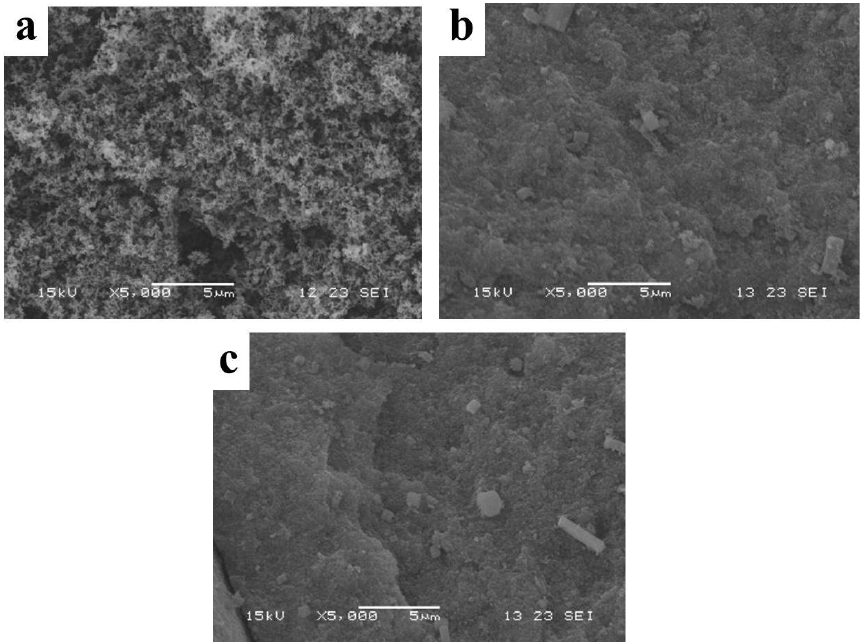
Figure 6. SEM images of ( a ) EP, ( b ) TM LDHs/EP and ( c ) QM LDHs/EP combustion products.